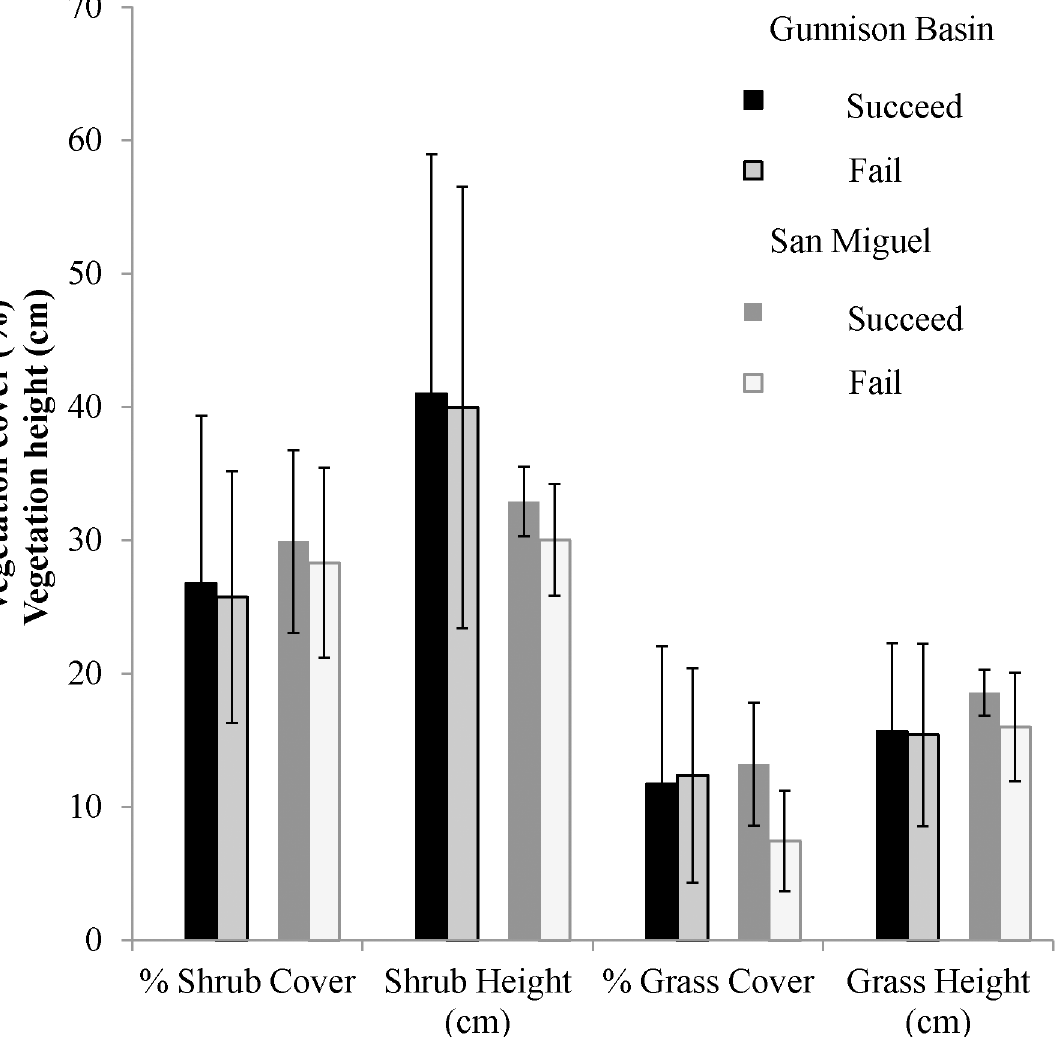
Fig 4. Average vegetation measurements (with standard errors) for nests in the Gunnison Basin population (n = 177) and the San Miguel population (n = 20) of Gunnison Sage-Grouse in Colorado, USA. Data are separated by nests that succeeded (i.e., eggs hatched) and nests that failed from 2005 –